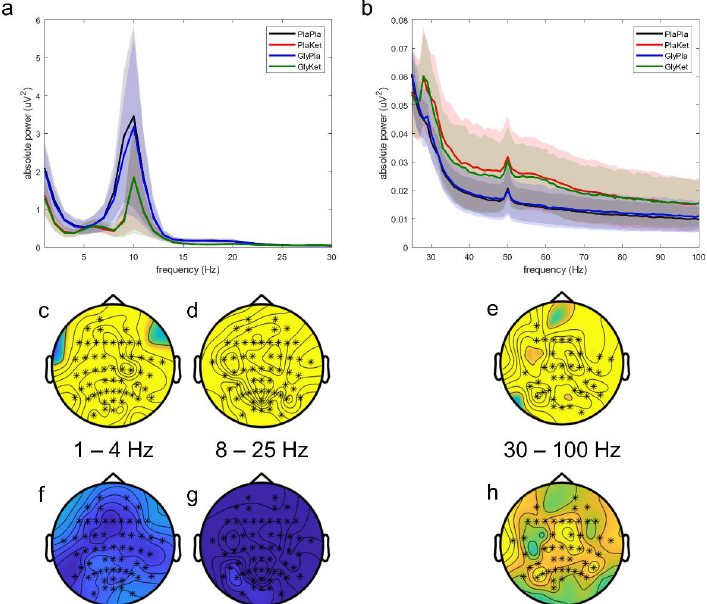
Figure 2. Mean resting state EEG power spectra across all electrodes in ( a ) the frequency range 1 – 30 Hz and ( b ) the frequency range 25 – 100 Hz for all four conditions: the PlaPla (black line), PlaKet (red line), GlyPla (blue line), and GlyKet condition (green line). The shaded areas depict the correspond- ing standard deviation of each condition. Topographical representation of statistical